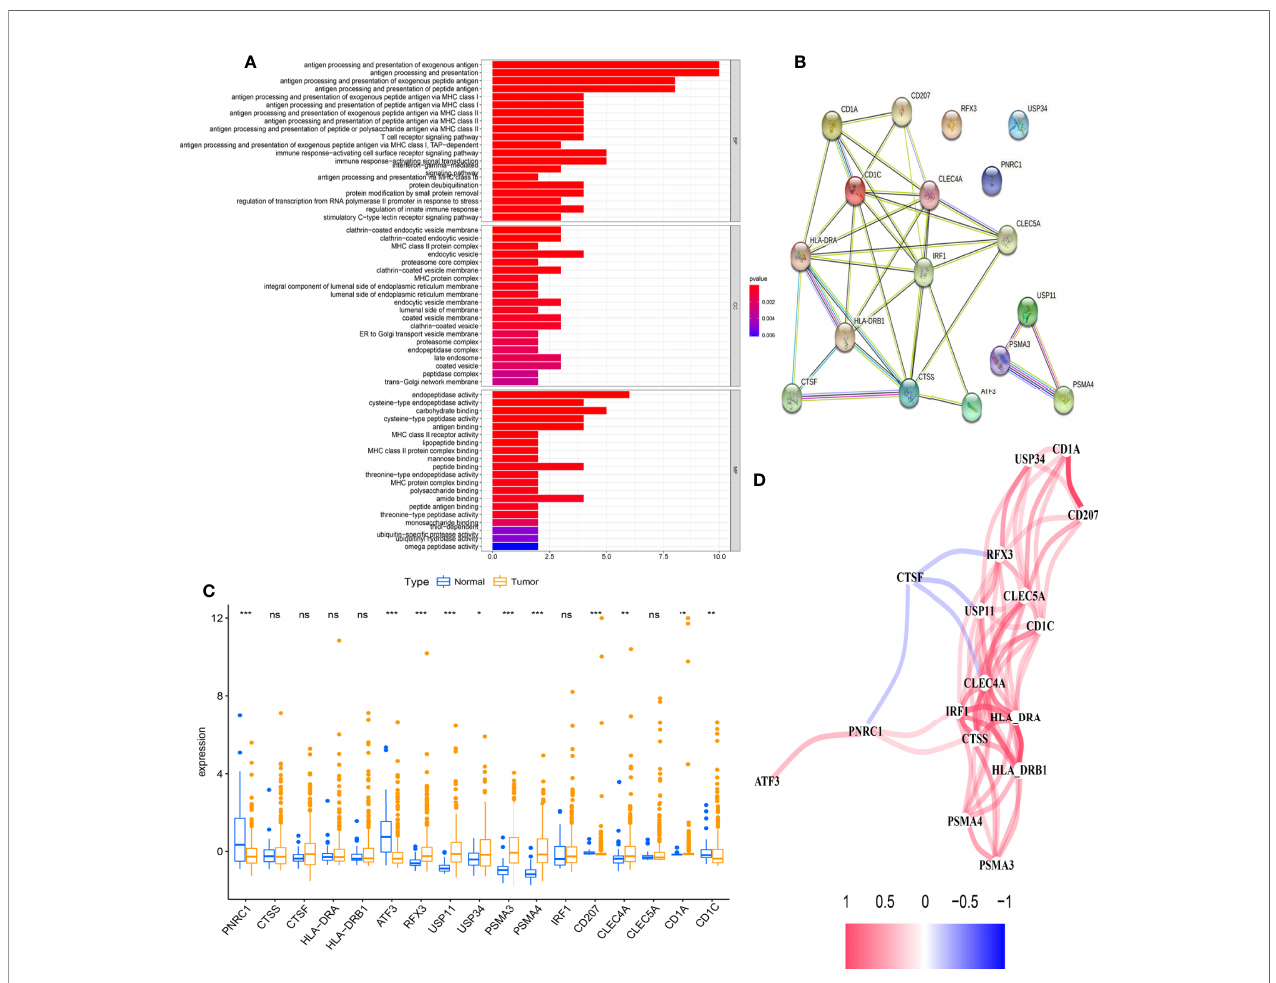
FIGURE 2 | Differential expression of antigen-presenting cell-related genes (ARGs) is closely associated with the biological progression of hepatocellular carcinoma (HCC). (A) Gene Ontology (GO) enrichment analysis based on the differences in 17 ARG expression levels between adjacent non-tumorous samples and HCC samples (p < 0.05). (B) The protein-to-protein interaction (PPI) network of 17 ARGs (coef > 0.4). (C) The boxplot displays the expression differences of 17 ARGs between adjacent non-tumorous samples and HCC samples (*p < 0.05, **p < 0.01, ***p < 0.001). (D) The correlation network of ARGs. The correlation coef fi cients are represented by different colors. ns, no signi fi